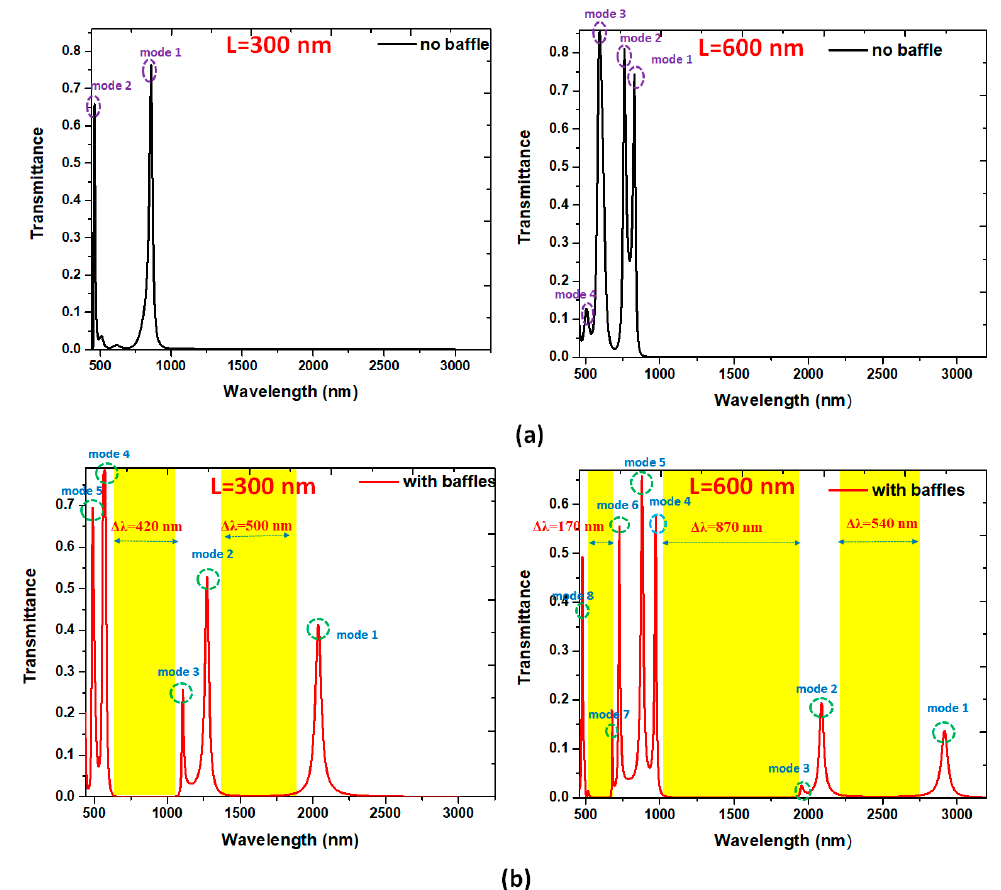
Figure 2. Transmittance spectra of the proposed plasmonic filter ( a ) without (black color) and ( b ) with (red color) Ag baffles in the rectangular cavity for L = 300 nm and L = 600 nm, respectively. The structural parameters w , g , and d are 50, 10, and 30 nm, respectively.